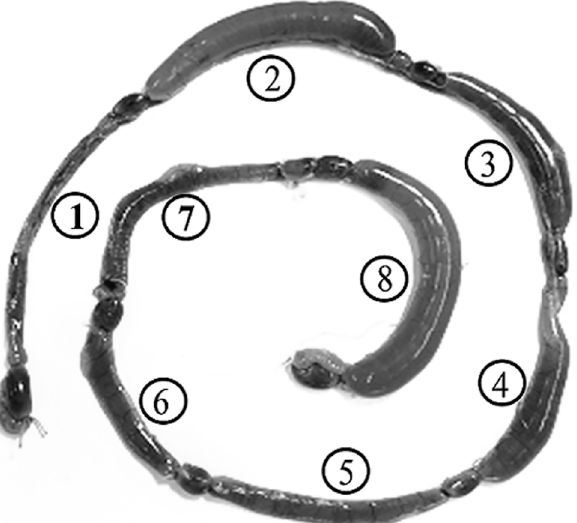
Fig 4. Dose-dependent effects of anethole on toxigenic V . cholerae (CRC41)-mediated fluid accumulation in ligated rabbit ileal loops (RILs). This RIL image is a representative of three independent observations. Inoculum size, fluid accumulation (F/A) ratio, bacterial colonization and CT production of each loop are summarized in Table